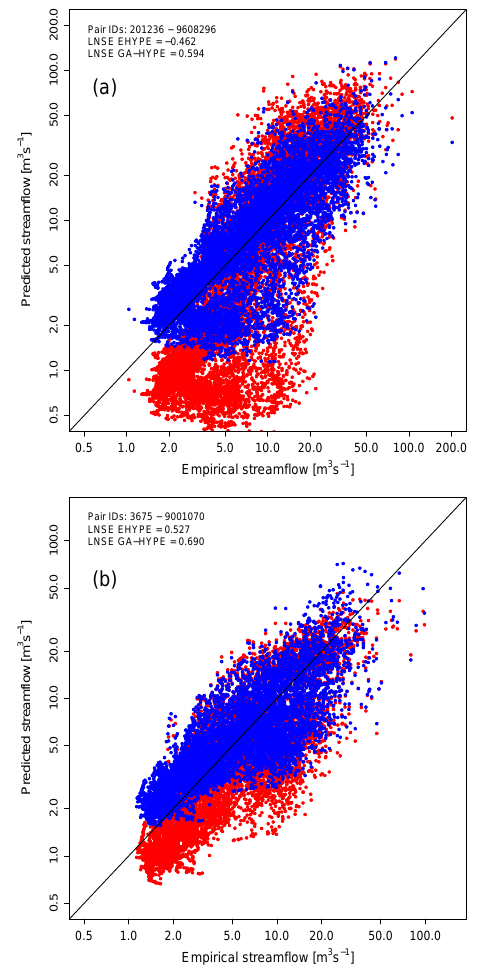
Figure 9. Scatter diagrams of empirical vs. simulated daily stream- flows for either E-HYPE (red dots) and GAE-HYPE (blue dots) for two representative sites, showing the cases in which the data- assimilation procedure respectively produced the largest (a) and smallest (b) degree of enhancement for the study area,